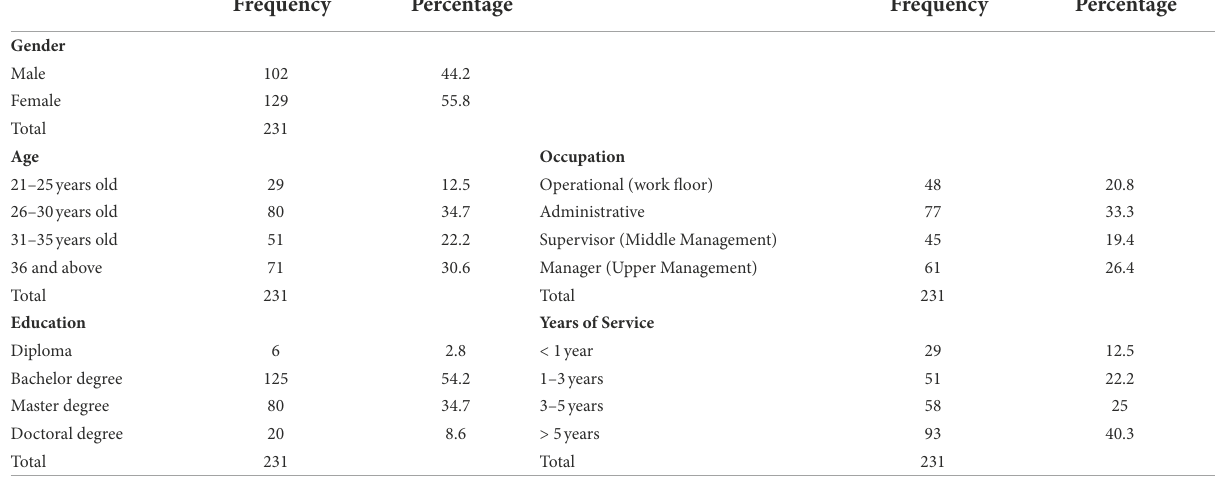
TABLE 2 Demographic profile of the